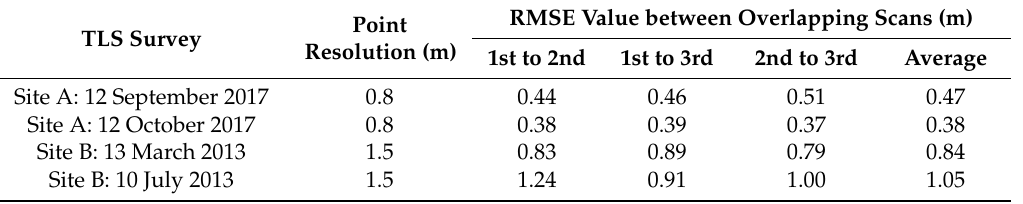
the registered multiple scans of TLS